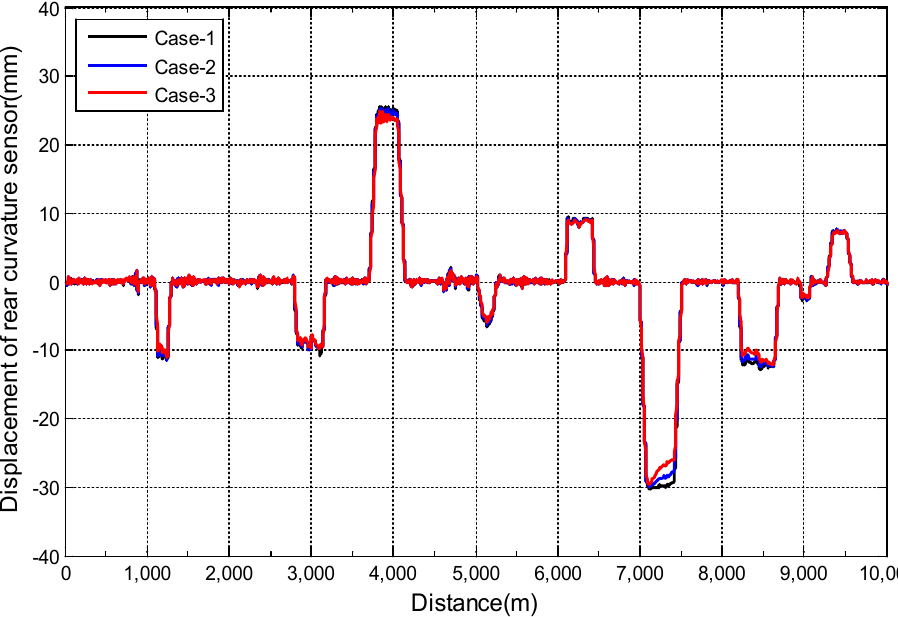
Figure 7. Displacement of rear curvature sensor from simulation.